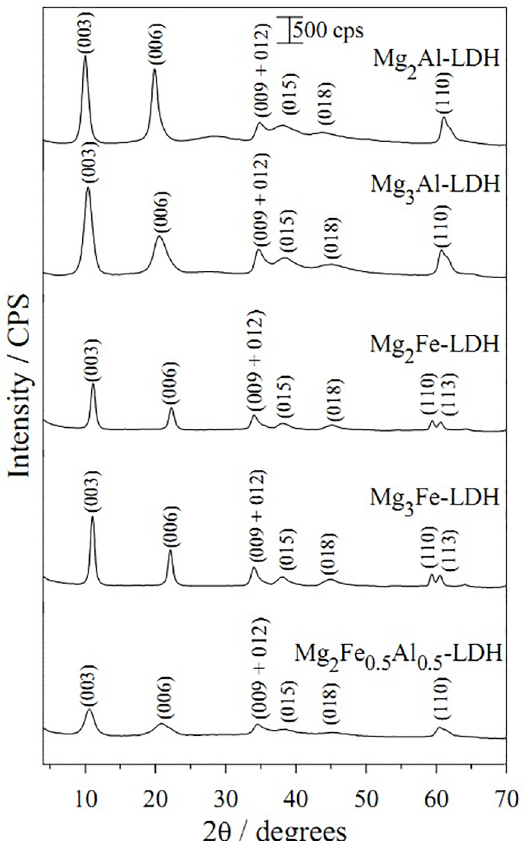
Al-LDH, Mg 2 Fe Al -LDH 2 0.5 0.5